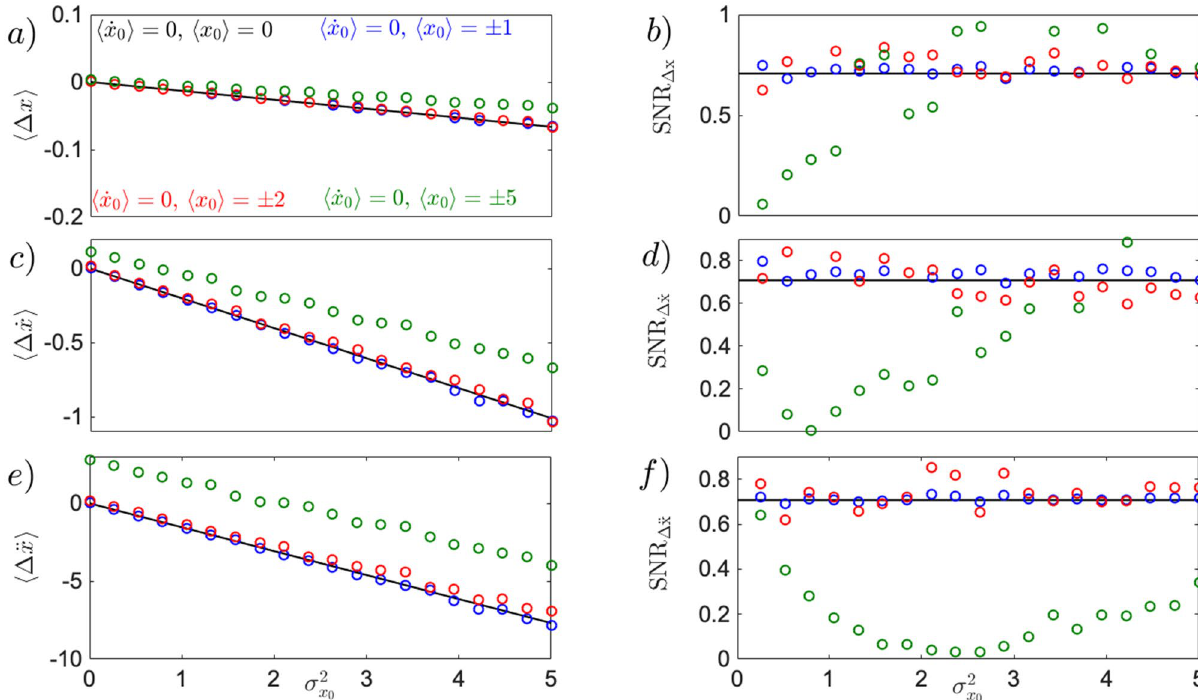
x 0 (cid:30) for position statistics (a,b) , (cid:31) x 0 0 , and 0 . Positioning the particle in different parts x 0 = �˙ � = ˙